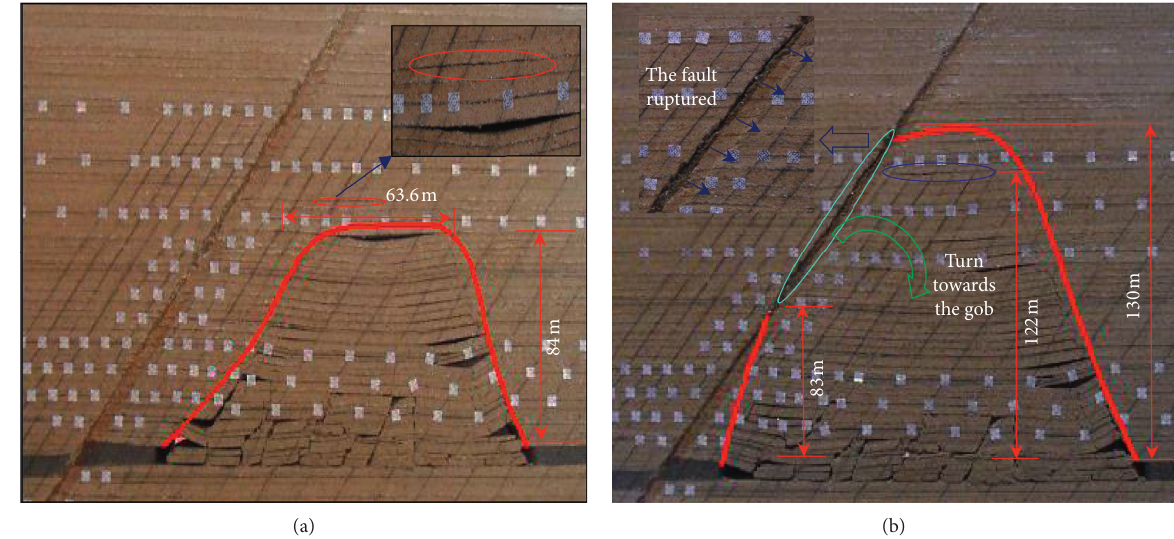
Figure 6: Overburden structure when the working face is 40m or 30m away from the fault. (a) Distance from the fault, 40m. (b) Distance from the fault,